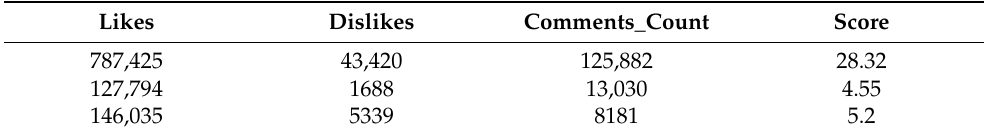
Table 5. The results of feature